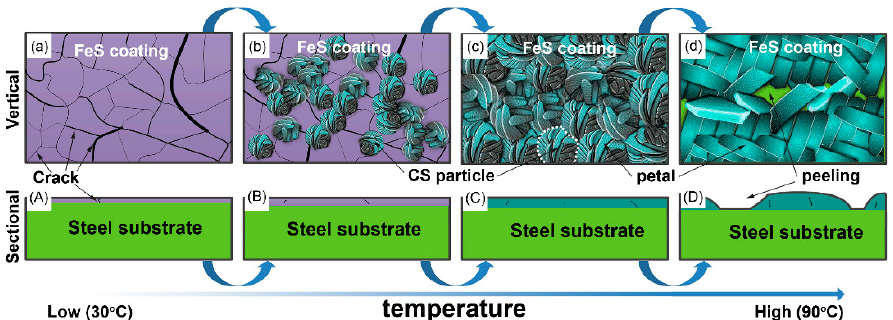
Figure 5. Schematic diagrams illustrating microstructure evolution during heating: ( a , A ) 30 °C; ( b , B ) 40 °C; ( c , C ) 50-70 °C; ( d , D ) 90 °C.